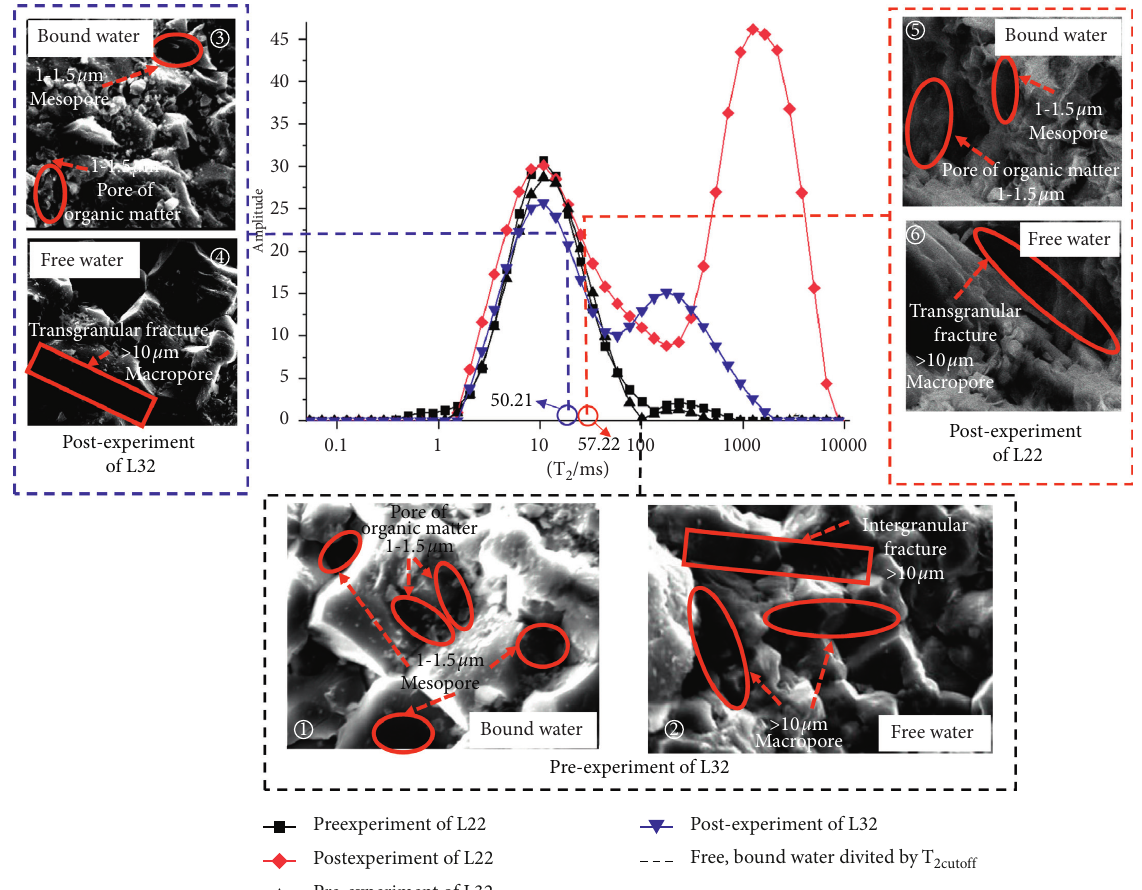
Figure 8: Mesopore structure of bound water and free water in L22 and L32 rock samples. ③ and ⑤ show the pore structure of bound water in the two rock samples after the test. ④ and ⑥ show the free-water pore structures after the test. ① and ② show the bound-water and free- water pore structures before the test.